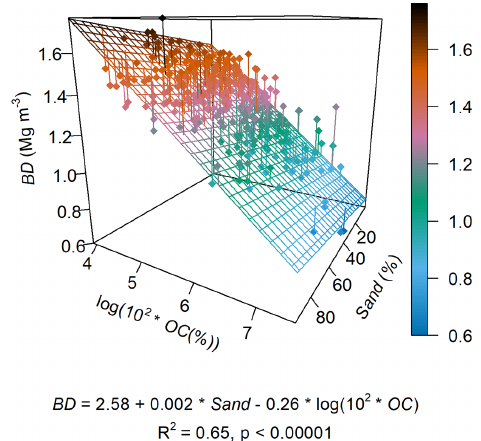
Figure A1. Pedotransfer function for estimating bulk density (BD) as a function of sand and organic carbon (OC) content. The regres- sion was fit using only the data for the A horizons in the 265 agri- cultural soil profiles from the UK SOILPITS dataset used in this